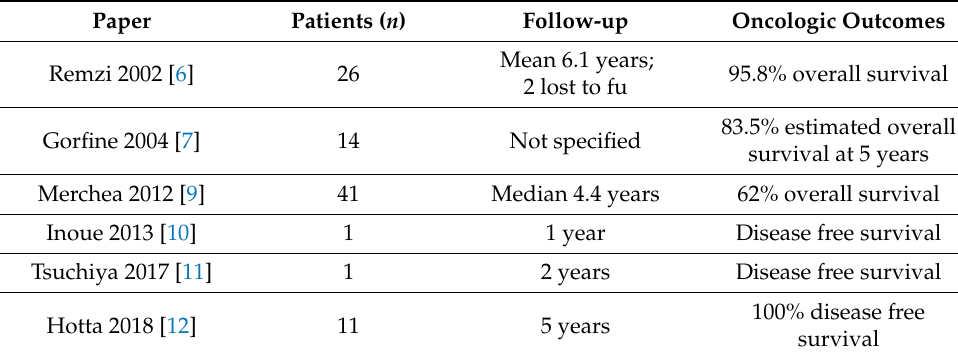
Table 2. Oncologic results of surgery for rectal cancer in ulcerative colitis.